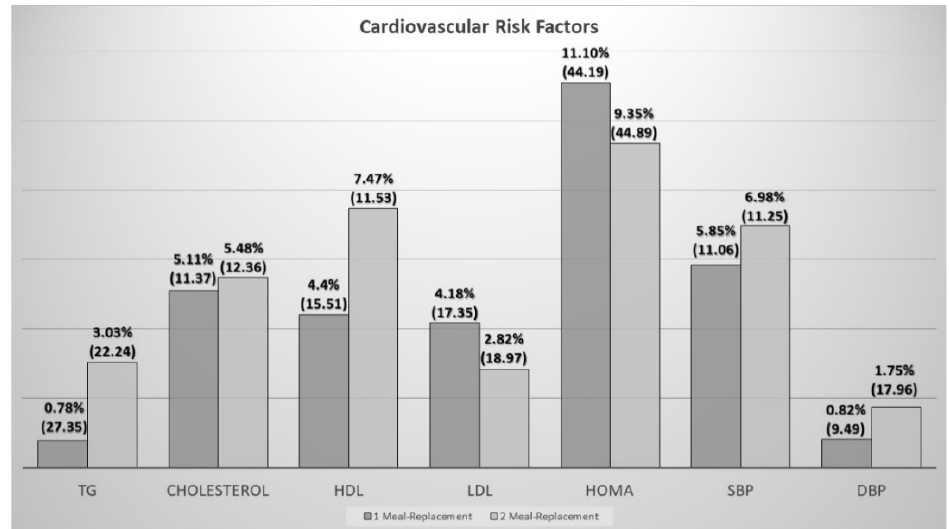
Figure 4. Comparison of changes over three months in cardiovascular risk factors (percentage of changes in the Y axis) and differences between the two groups of intervention. TG: triglycerides; HDL: high density lipoprotein; LDL: low density lipoprotein; SBP: systolic blood pressure; DBP: diastolic blood pressure.